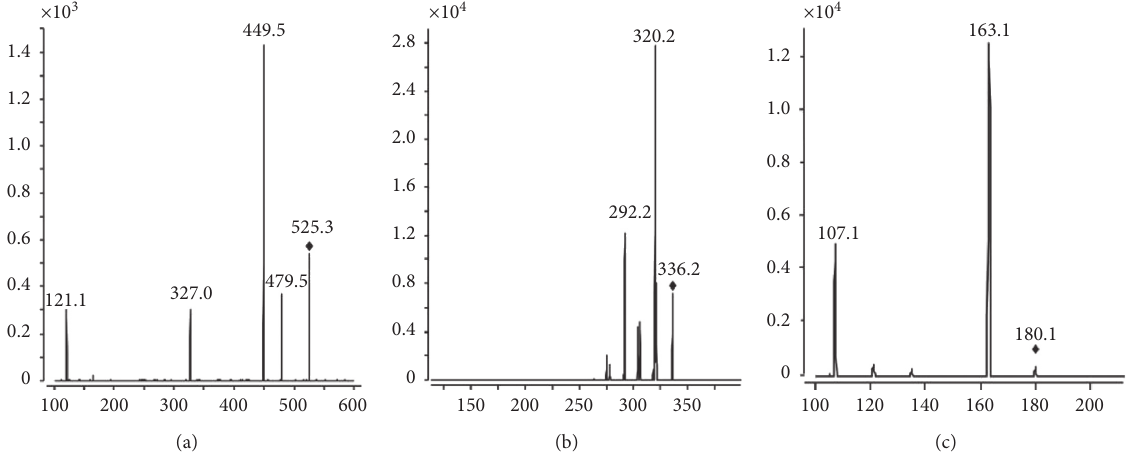
Figure 3: Product ion spectra of PF (a), BBR (b), and IS